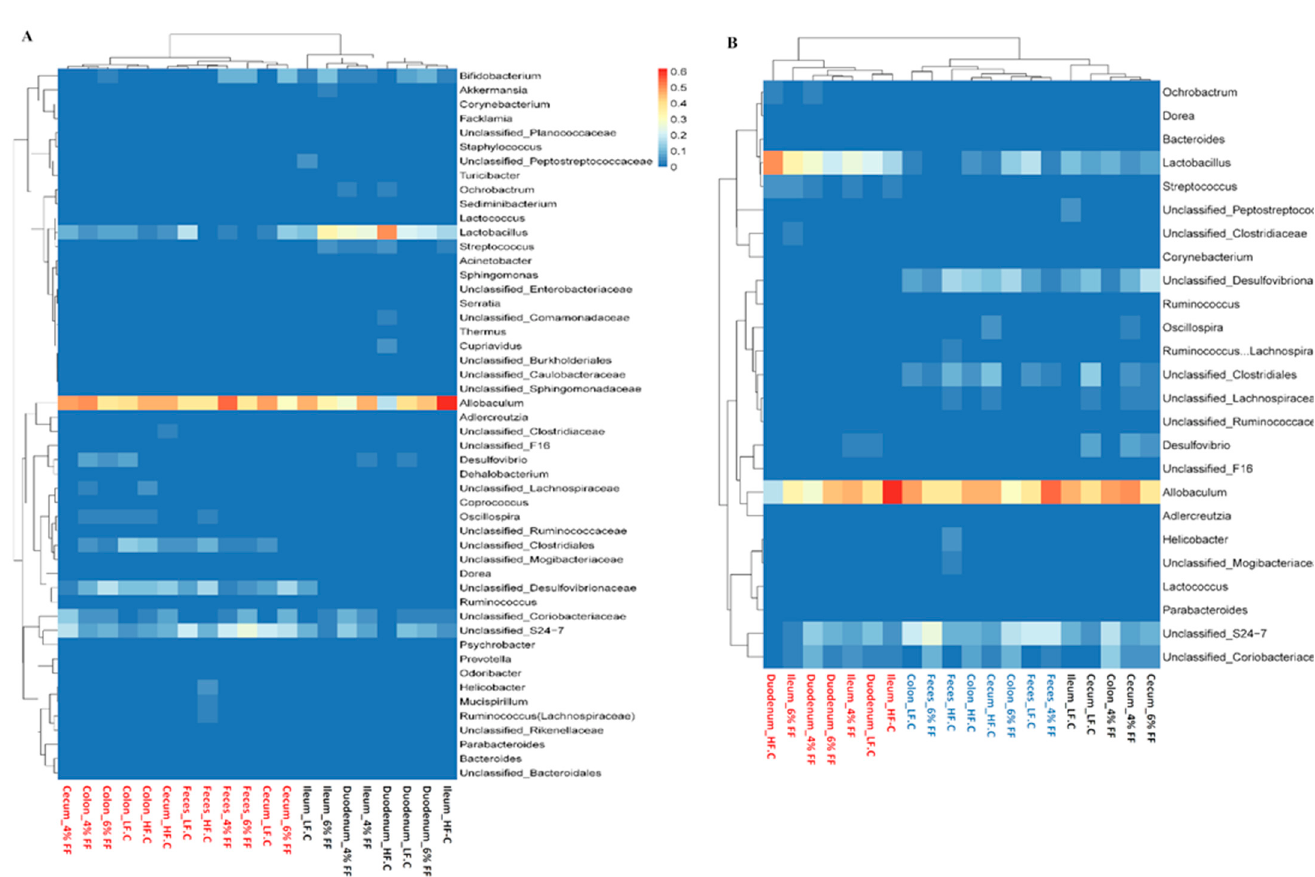
Figure 7. Microbial composition and changes in different intestinal segments: ( A ) clustering heat map of the first 50 genera, and ( B ) clustering of differential genera among intestinal segments in different groups by LEfSe analysis.